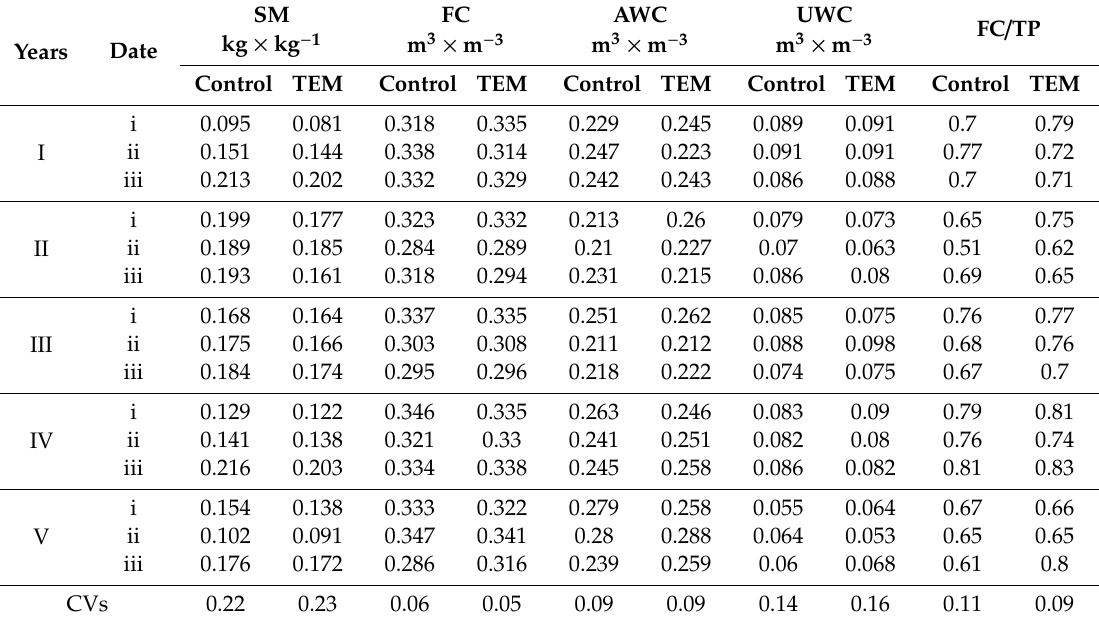
Table 4. Mean values of soil properties on sampling